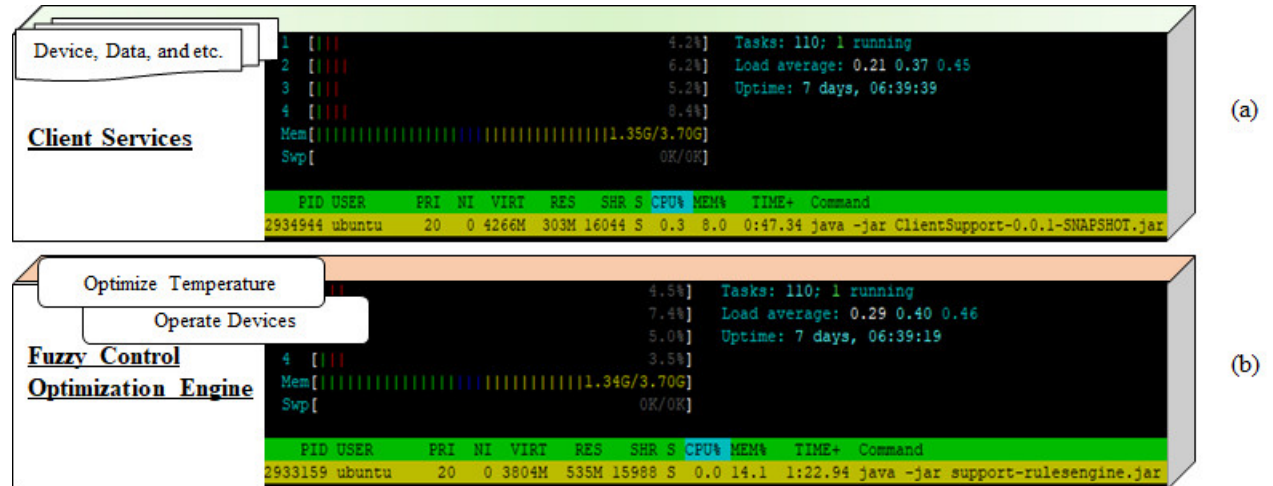
Figure 10. Implemented Client Services and Intelligent microservices of the proposed embedded edge computing. ( a ) Exe- cuted Client Services. ( b ) Executed Optimization Engine and Fuzzy Control.